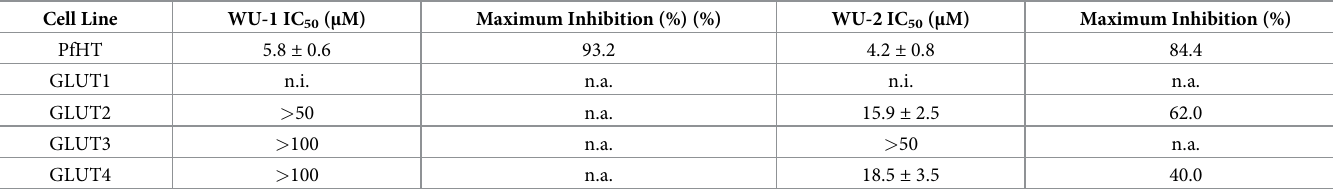
Table 1. IC 50 concentrations and maximal inhibition for WU-1 and WU-2 for class I GLUT overexpressing cells. Cell